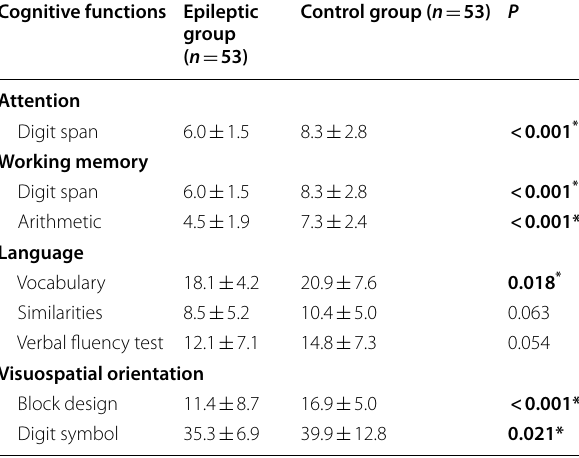
P indicates the P value for comparing between different categories SD standard deviation * Statistically significant at P 0.05 ≤ Table 3 Relation between cognitive functions and epilepsy-related characteristics among the epileptic group ( n